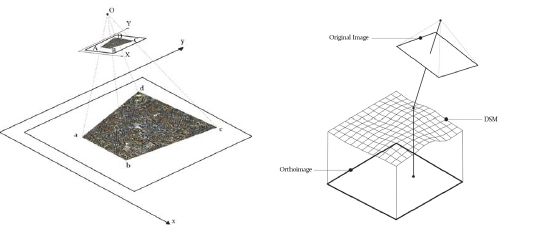
Figure 7: On the left the rectified image construction schema. On the right the orthophoto simple schematization.